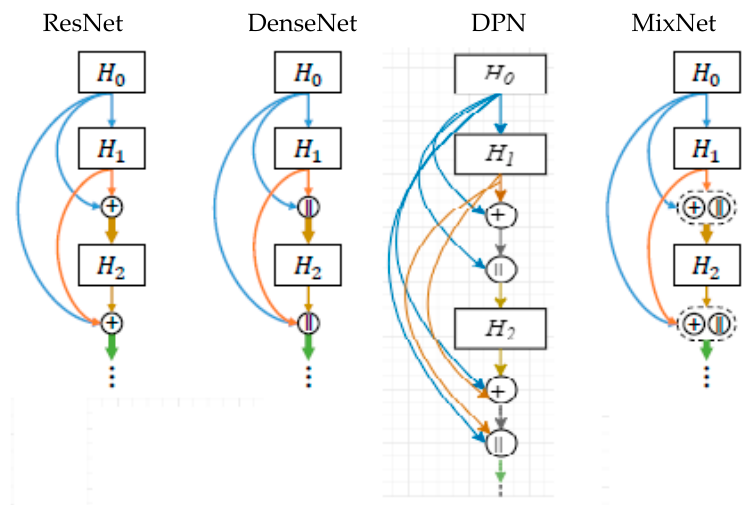
Figure 4. Modern CNN connection architecture.